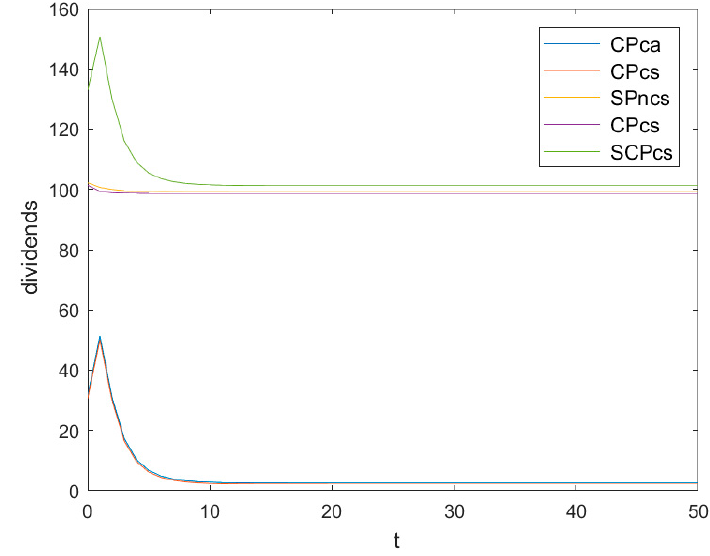
Figure 5. Evolutions of different optimal dividends.